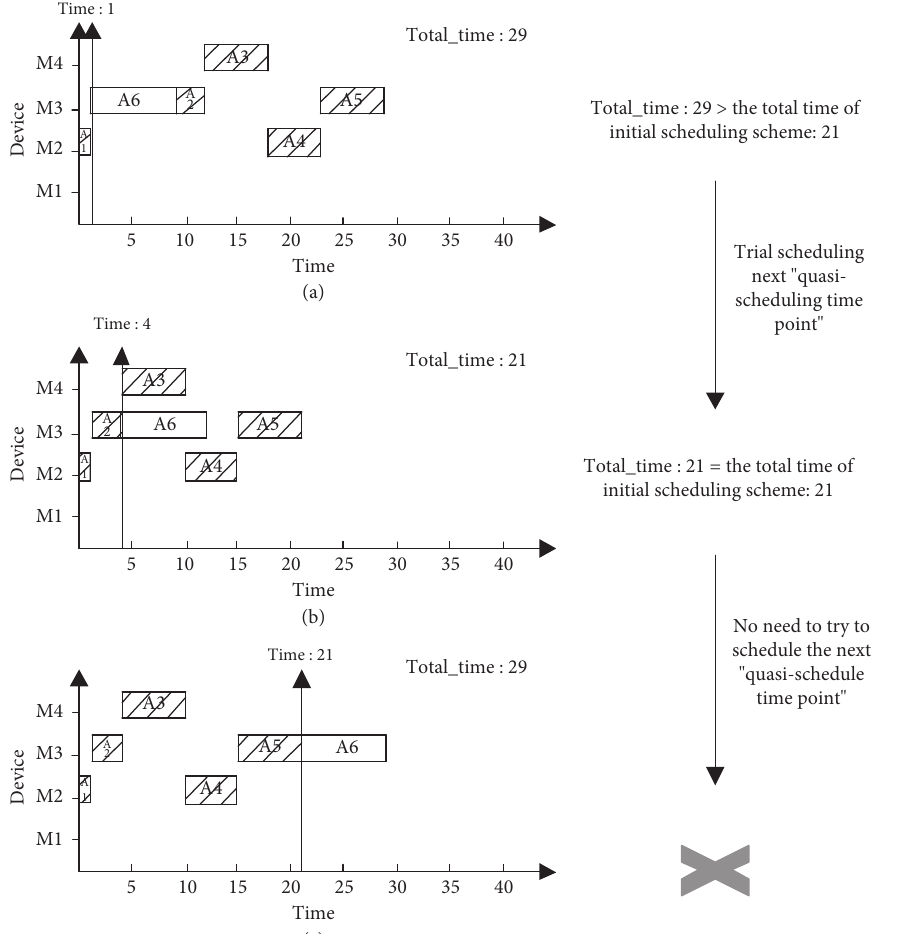
Figure 4: Gantt chart of each trial scheduling scheme of process A6. (a) The scheduling scheme is obtained by trial scheduling at quasi- scheduling time point “1.” (b) The scheduling scheme is obtained by trial scheduling at quasi-scheduling time point “4.” (c) The scheduling scheme is obtained by trial scheduling at quasi-scheduling time point